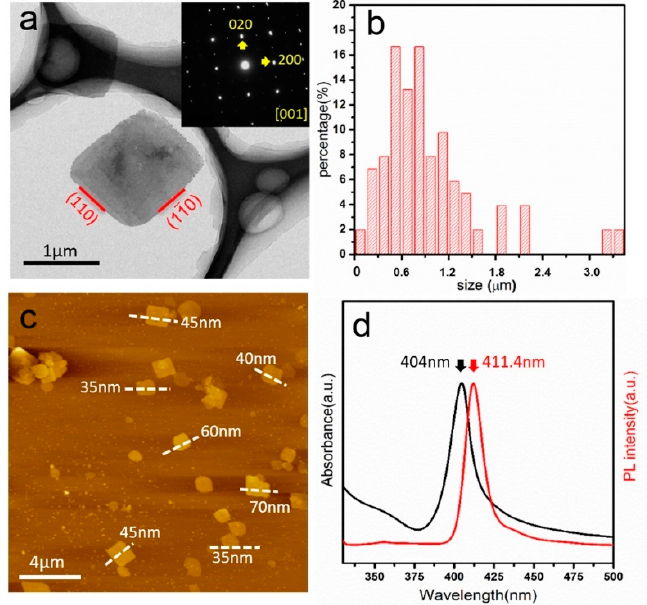
Figure 1. ( a ) TEM image of the as-synthesized BA 2 PbBr 4 nanosheets along the [001] zone axis and the corresponding SAED pattern (inset). ( b ) Side length distribution of the as-synthesized BA 2 PbBr 4 nanosheets; ( c ) AFM image of the BA 2 PbBr 4 nanosheets with the measured thickness results; and ( d )